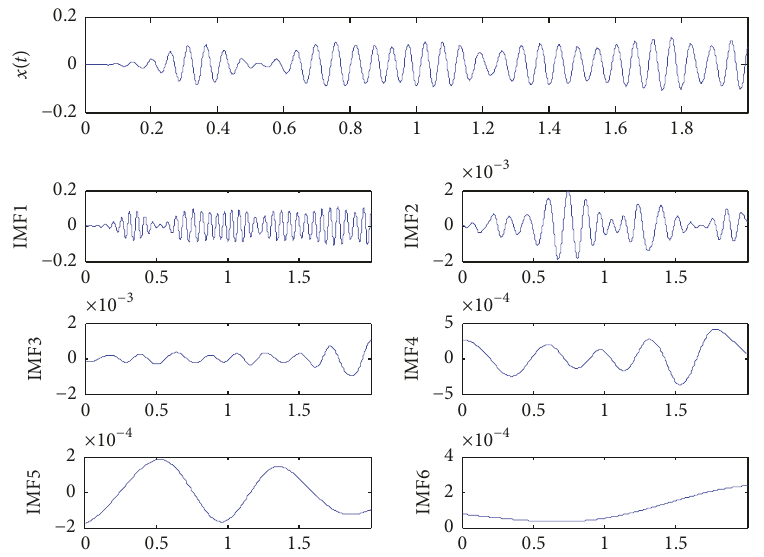
Figure 3: First-order vibration response of node 15 in the derrick steel structure and EMD.